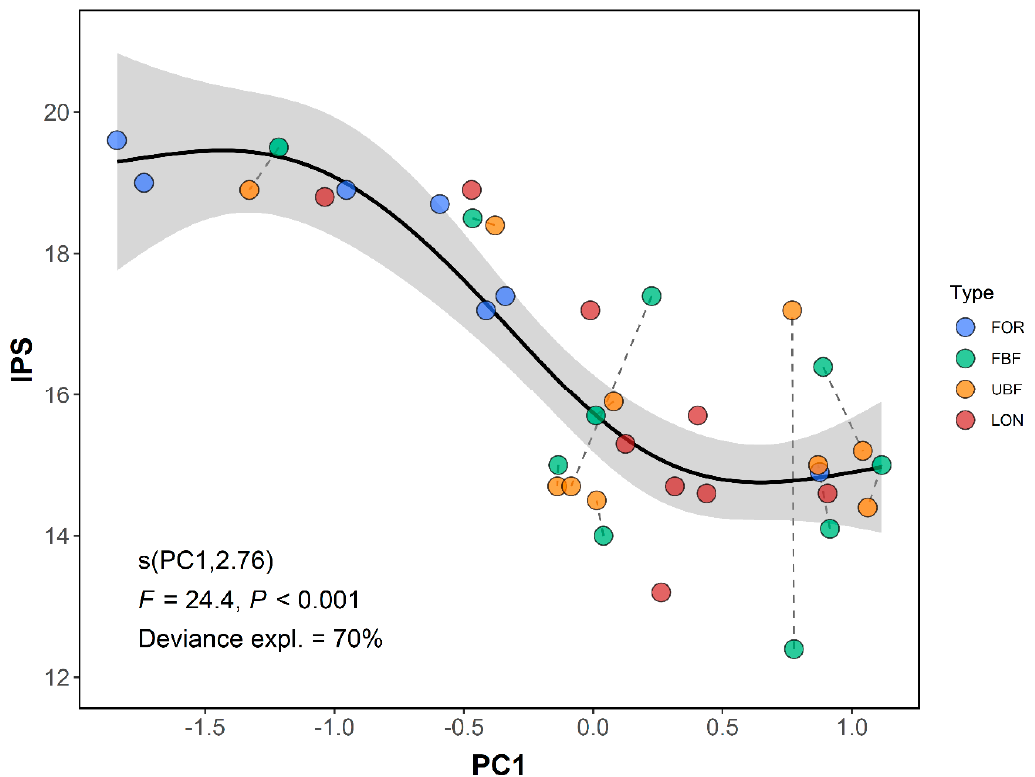
Figure 2. Generalized additive model showing adverse impacts of decreasing water quality on diatom communities in the Oslo basin. The non-linear decrease of the IPS index (L´Indice de Polluosensibilité Spécifique, aka the Specific Pollution Sensitivity Index [34]) is a response to increasing catchment urbanization (PC1). Site types are indicated by different colors; dashed lines indicate site pairs.